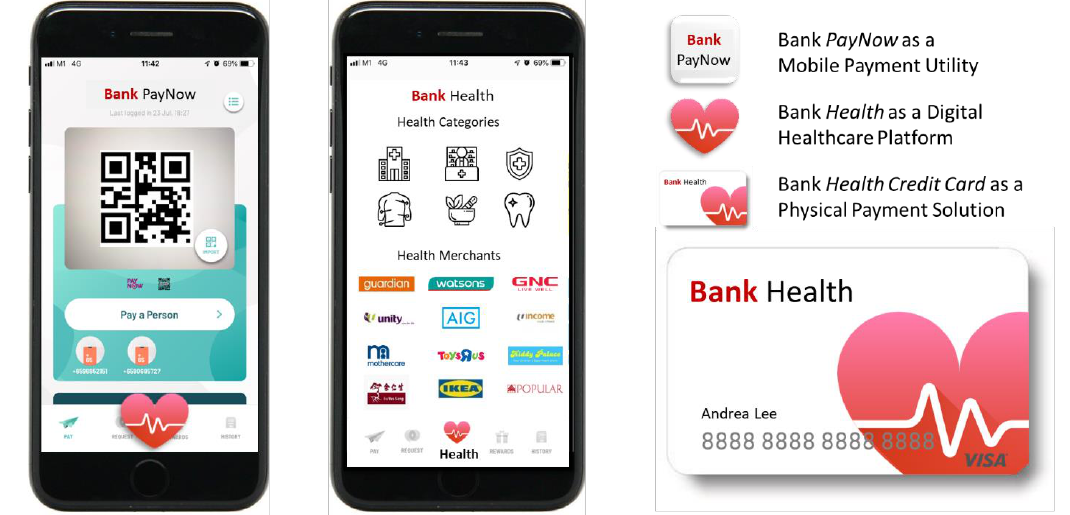
Figure 17. Illustration of the healthcare